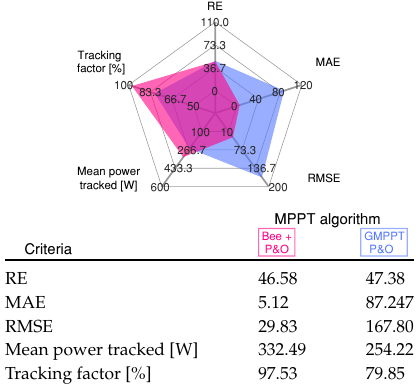
Figure 14. Comparative analysis of the MPPT methods for Scenario 4 shown in Figure